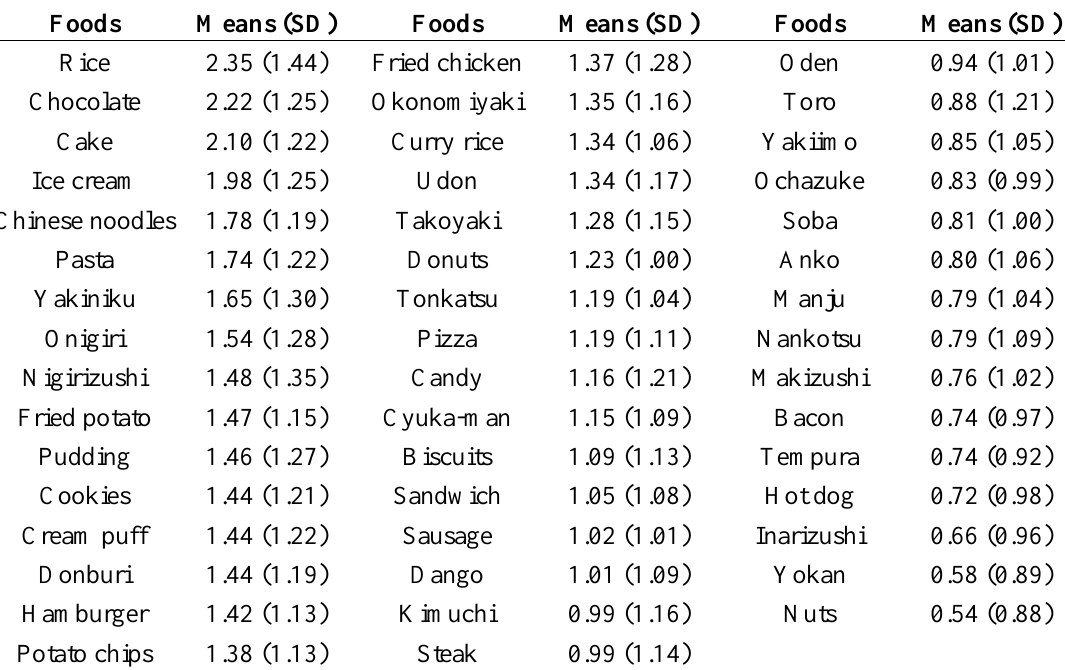
Table 1. Means (standard deviations, SD) of craving scores.